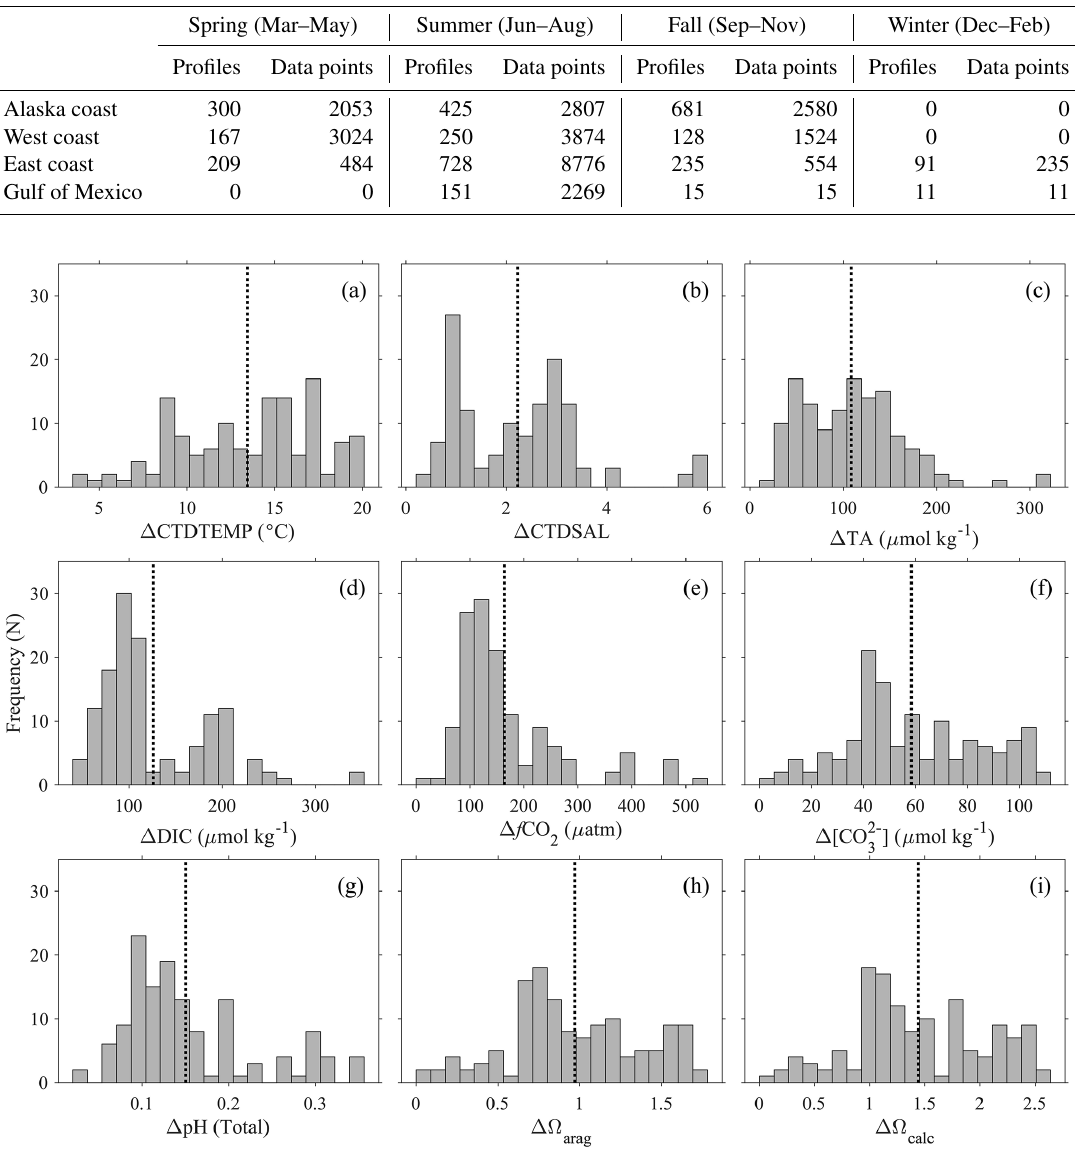
Figure 6. Seasonal amplitudes (maximum minus minimum values within a group of close by stations) of (a) temperature (CTDTEMP), (b) salinity (CTDSAL), (c) total alkalinity (TA), (d) dissolved inorganic carbon (DIC), (e) fugacity of carbon dioxide ( f CO 2 ), (f) carbonate ([CO 2 − ], (g) pH on total scale, (h) aragonite saturation state ( (cid:127) arag ), and (i) calcite saturation state ( (cid:127) calc ) in the surface water. The y axis, 3 “frequency (N)”, refers to the number of groups of stations. The dotted lines show the average value of the variabilities. This analysis is based on groups of profiles that are within 1km of each